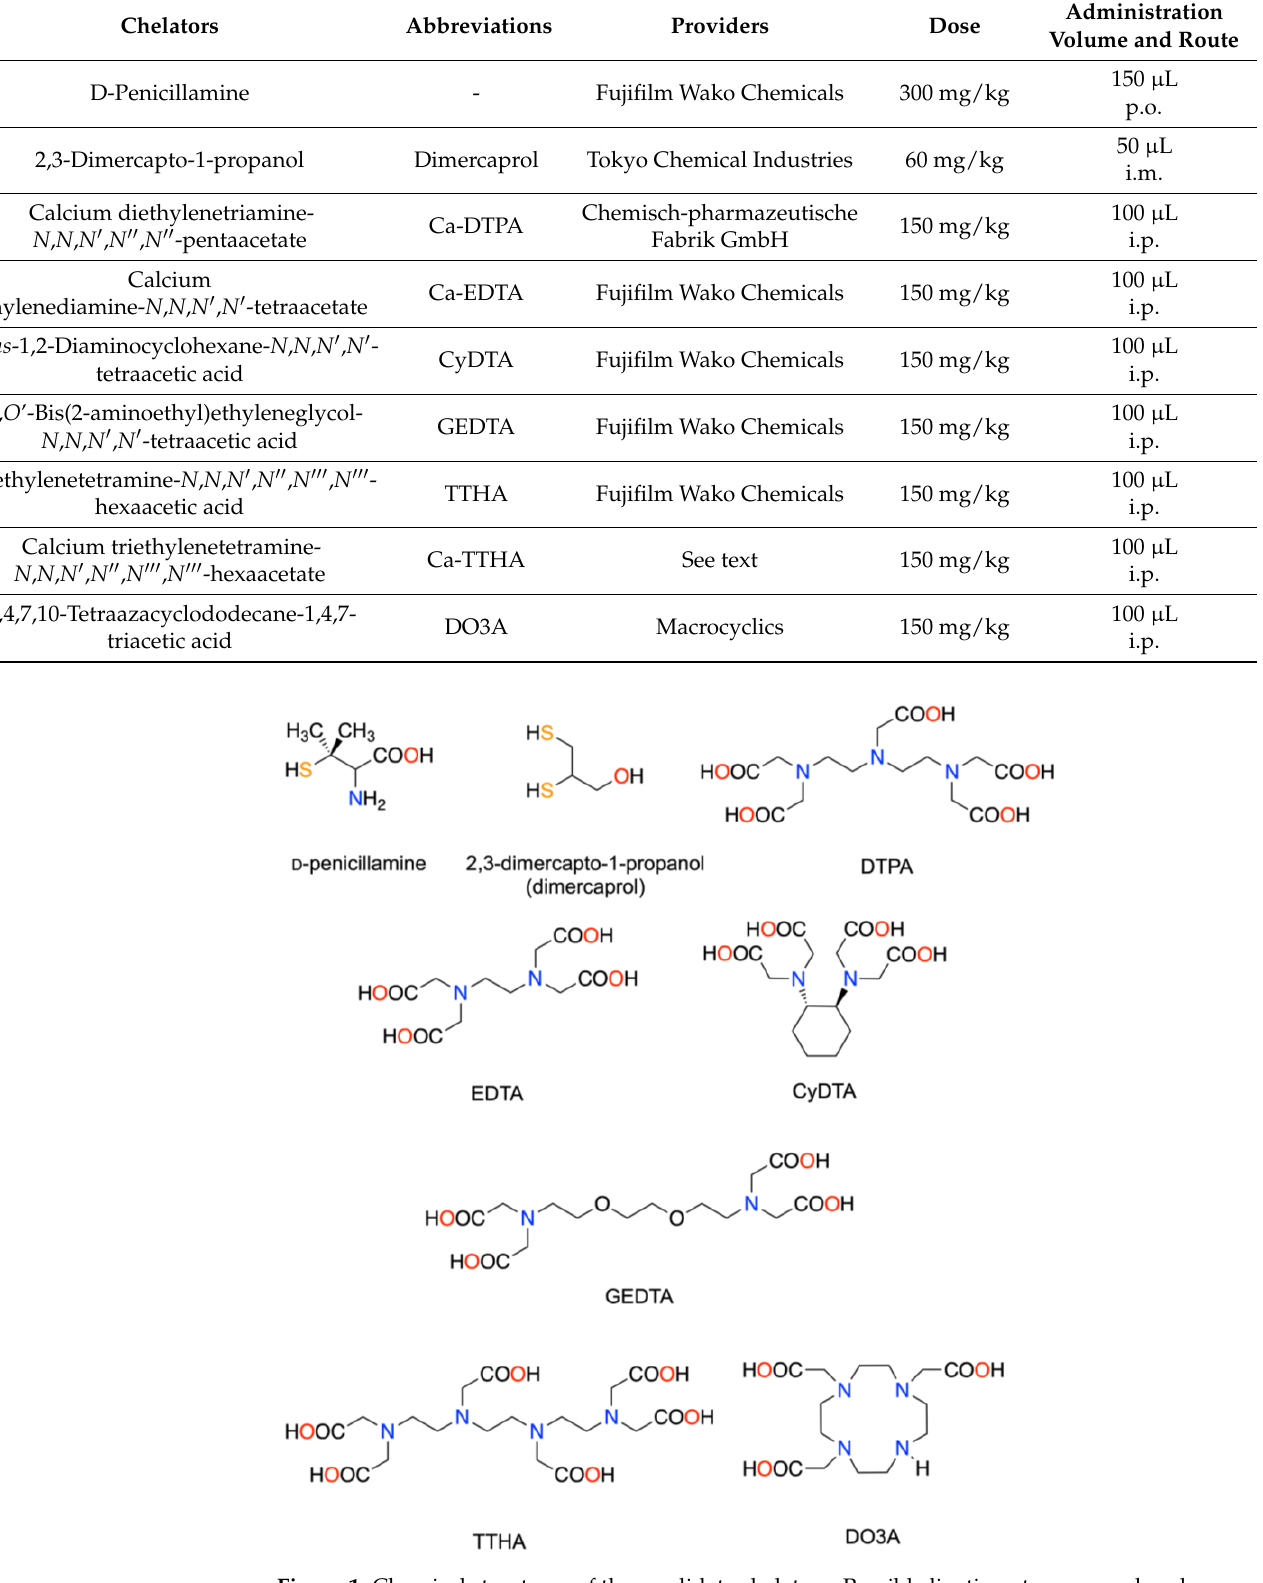
Figure 1. Chemical structures of the candidate chelators. Possible ligating atoms are colored.